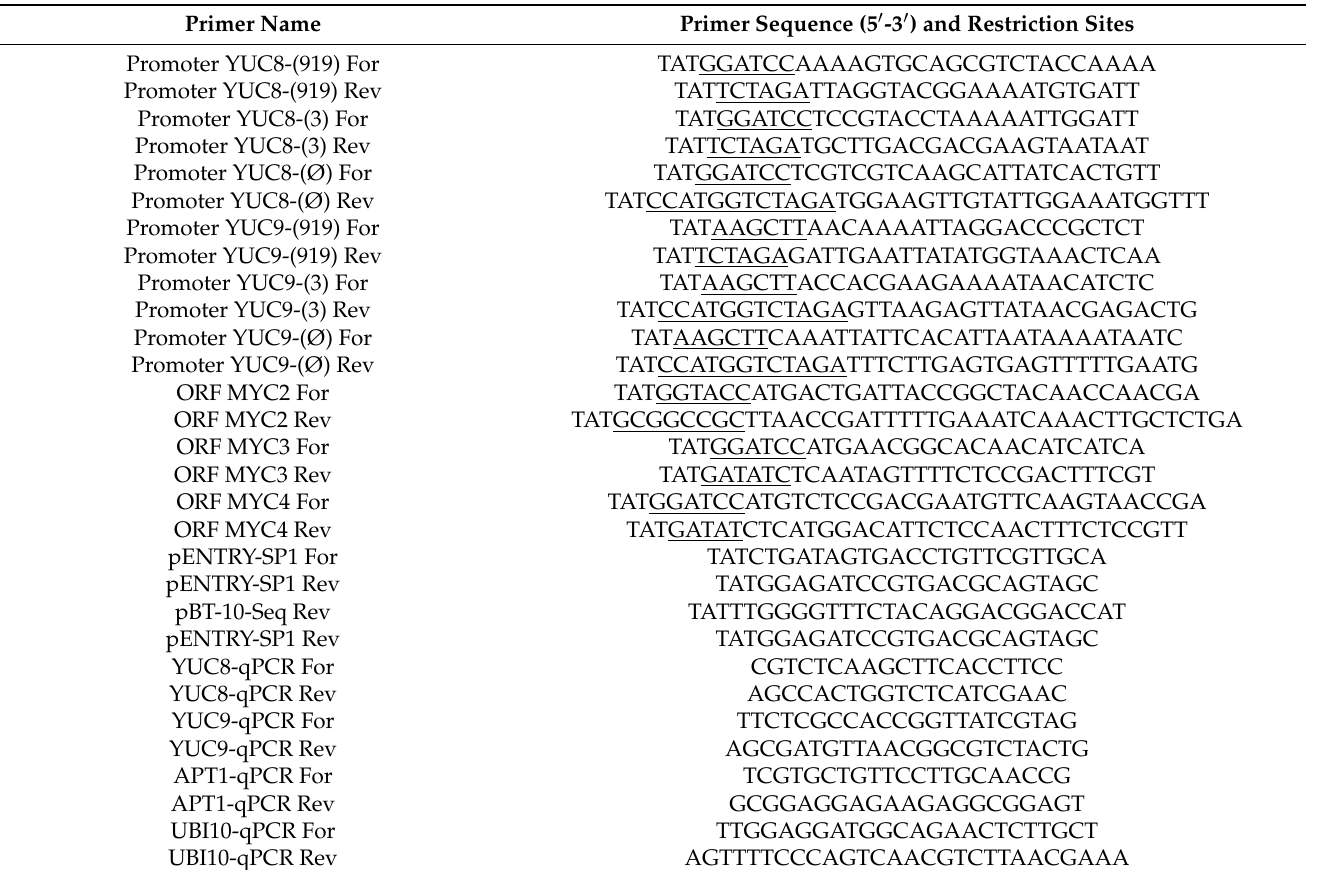
Table A1. List of primers used for cloning and qRT-PCR analysis (https://quantprime.mpimp-golm.mpg.de/, accessed on: 8 September 2021)